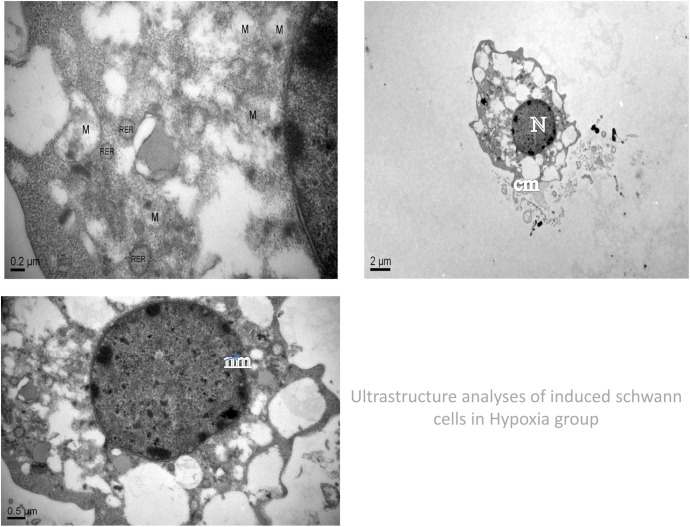
Images from the hypoxia group reveal partial cell membrane disintegration, the whole cell vacuole.organelle fragmentation and disintegration, lysosomal vesicles appear, swelling of the rough endoplasmic reticulum and mitochondria, mitochondria vacuole, mitochondrial cristae shortening and rupture, partial swelling and rupturing of the nuclear membrane, and the nucleolus shrinkage. M: mitochondria RER:rough endoplasmic reticulum N:nucleolus, nm: nuclear membrane, cm: cell membrane.